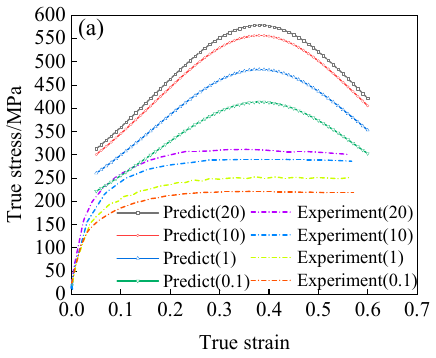
Figure 15. The predicted results based on the Equation (21): ( a ) T = 1073 K; ( b ) T = 1373 K. When the stress level parameter is only related to strain, and other parameters function of Equation (21) remain the same, that is to say, in the calculation of the flow stress by using Equation (21), just replace the function of level parameter α ( ε , T ) with α ( ε ) , the expression of the α ( ε ) satisfies Equation (10). Through the transformation mentioned above, the predicted results of flow stress are shown in Figure 16. It can be seen that the modified model’s predicted results are highly consistent with the experimental results.